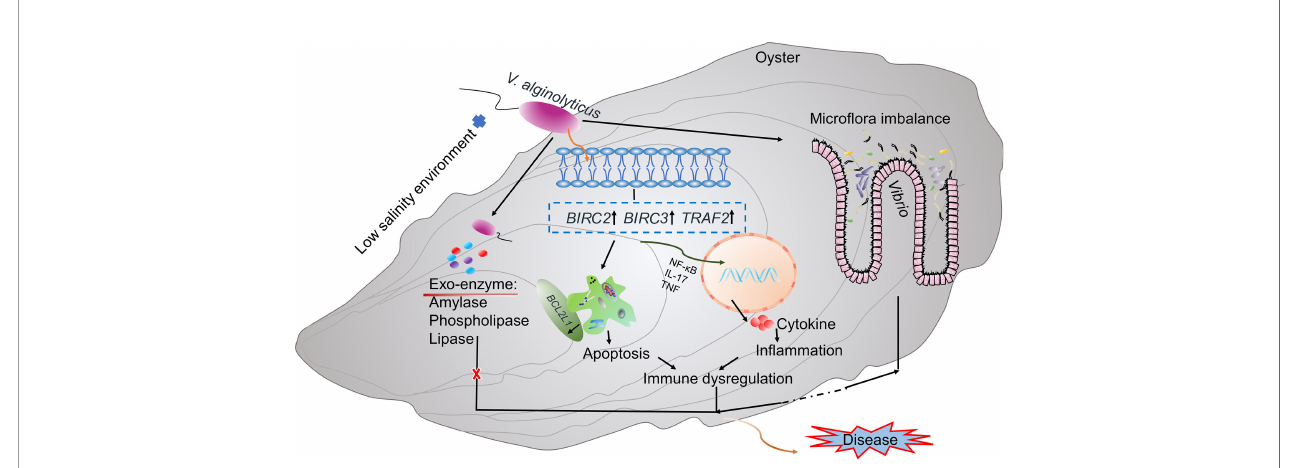
FIGURE 5 | A proposed model for synergistic interaction of low salinity stress, Vibrio infection and host response. Micro fl ora imbalance and immune dysregulation caused by low salinity stress are hypothesized to cause high mortality of oysters infected with V. alginolyticus in low salinity